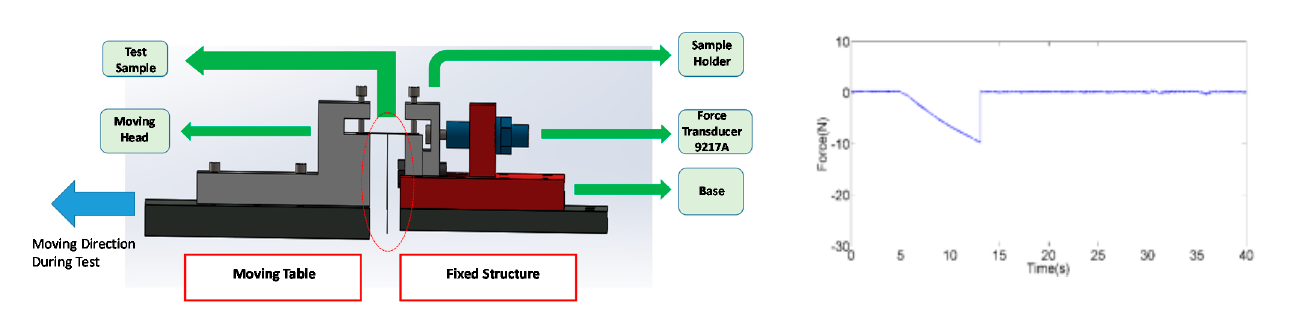
Figure 2. Peeling test ( a ) equipment and ( b ) recorded force data.